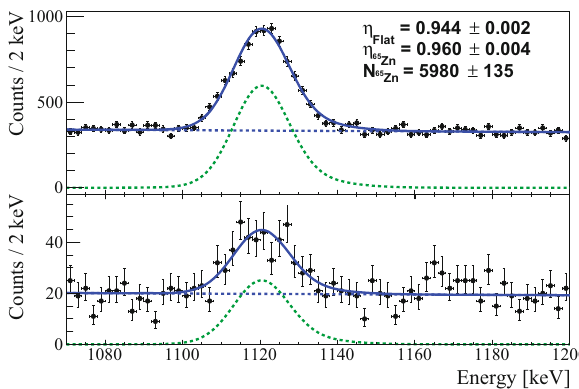
Fig. 3 γ Peak produced by the decay of 65 Zn. Top: events in which the acquisitionwindow containsasingle pulse.Bottom:eventsinwhichthe acquisition window contains more than one pulse. The spectra are fit- ted simultaneously with an unbinned extended maximum likelihood fit (RooFitanalysisframework)withtwocomponents:thefunctionmodel- ing the detector response Σ(μ,σ( E )) , and an exponential background